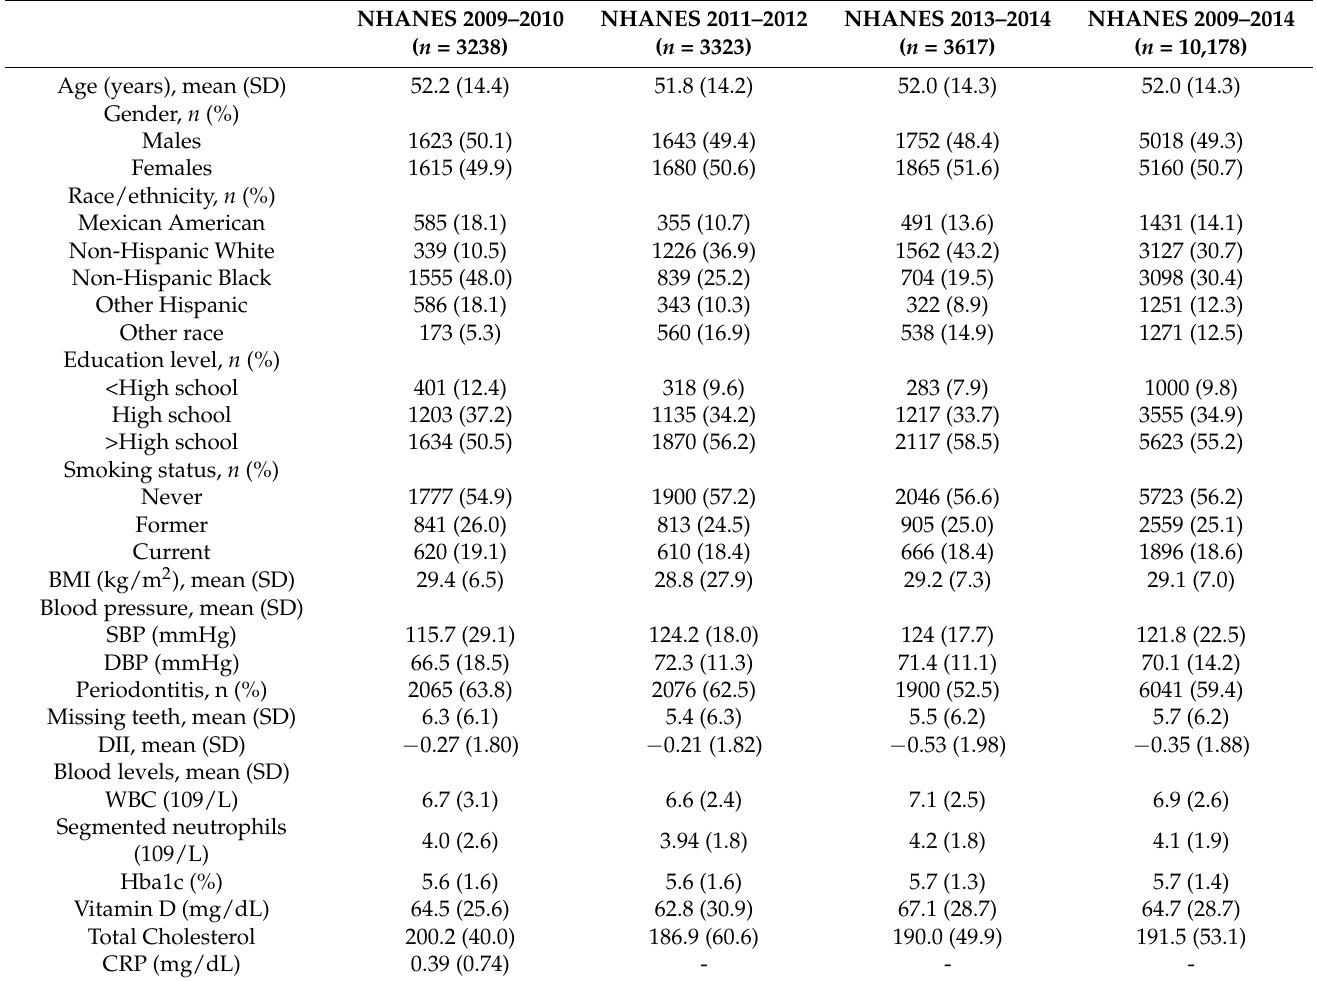
Table 1. Sample characteristics ( n =